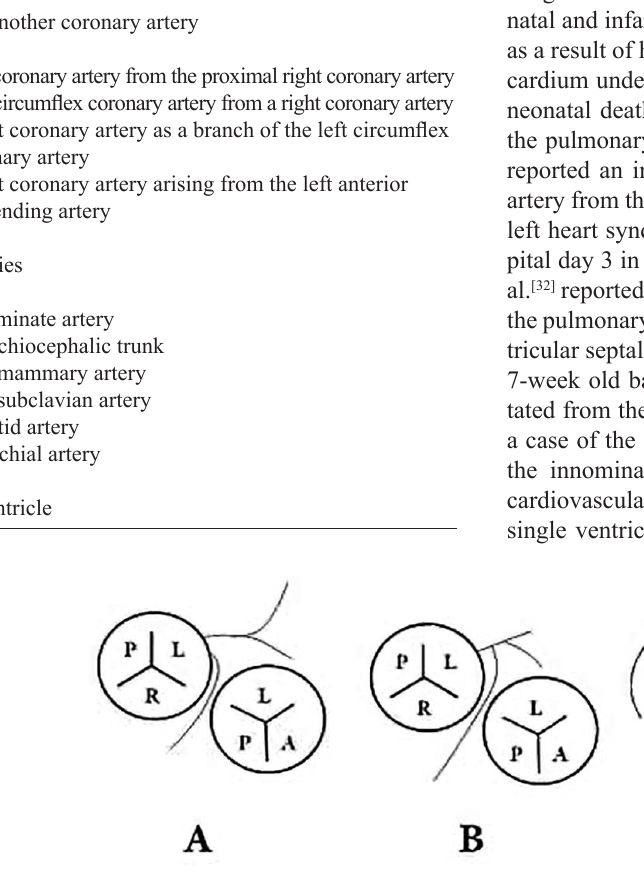
Fig. 1 - Right coronary artery arising from the left coronary sinus [10] : (A) from a separate ostia with the left coronary artery; (B) from the left main stem coursing between the aorta and pulmonary artery; and (C) from the left main stem with a retroaortic